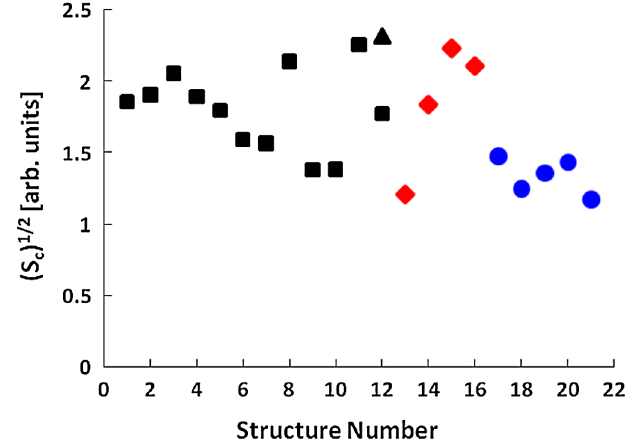
is plotted for the data pre- c